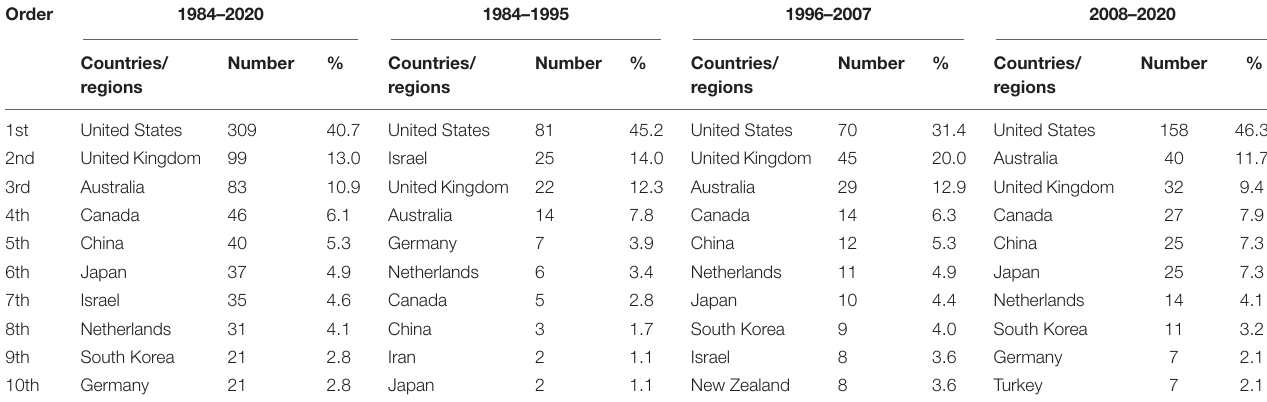
TABLE 6 | Top 10 most productive countries/regions.